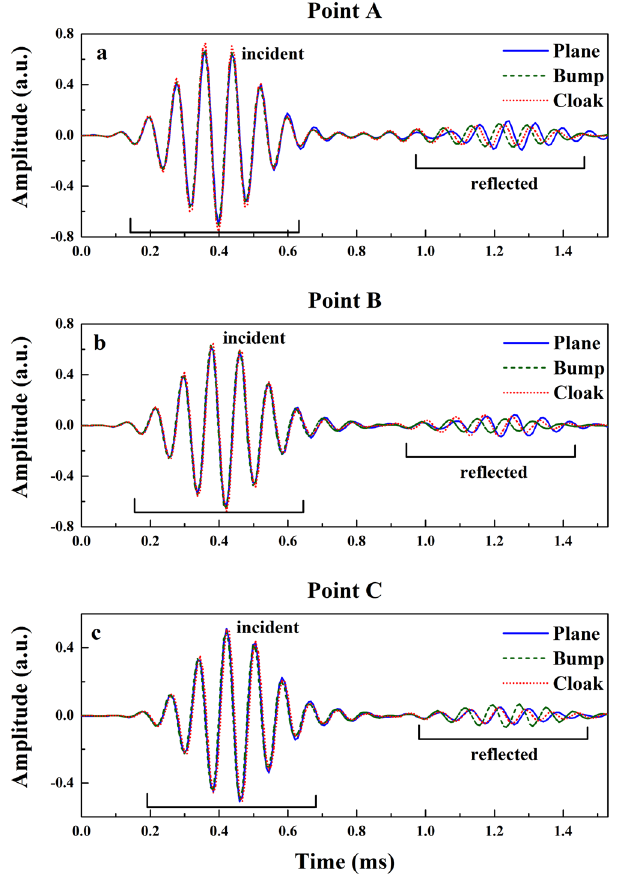
Figure 6. Extracted time domain signals at 12 kHz. The locations of A, B and C are specified in Fig. 3a. Each plot shows the incident wave and the scattered wave for three scenarios: the soft plane underwater (shown as blue solid lines), the soft bump underwater (shown as green dash lines), and the cloaked soft bump underwater (shown as red dot